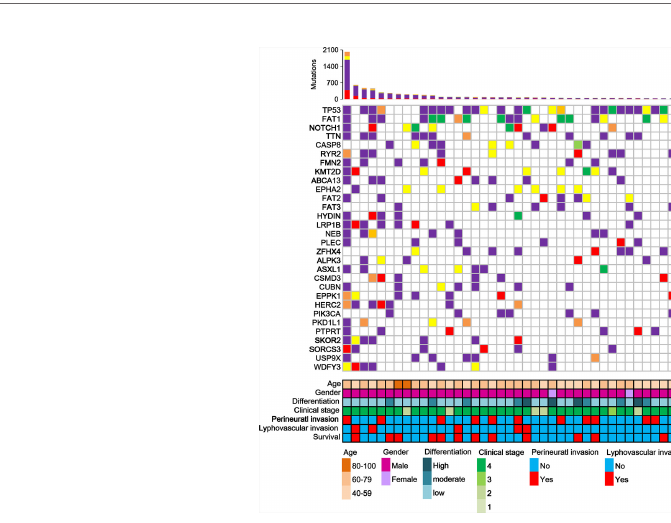
FIGURE 5 | Distribution of the 20 most frequently mutated genes in the OSCC patients. Each column represents an individual OSCC patient, and each row denotes a gene and clinical features. Clinical features and mutation types are color coded as